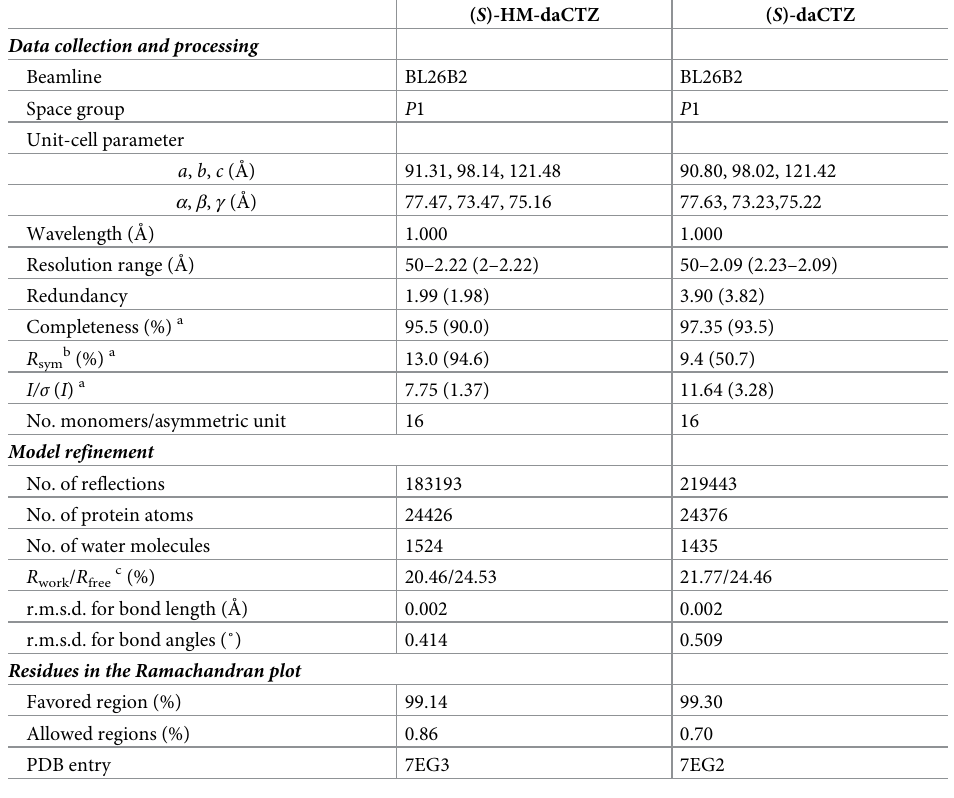
Table 2. Statistics of data collection and structure